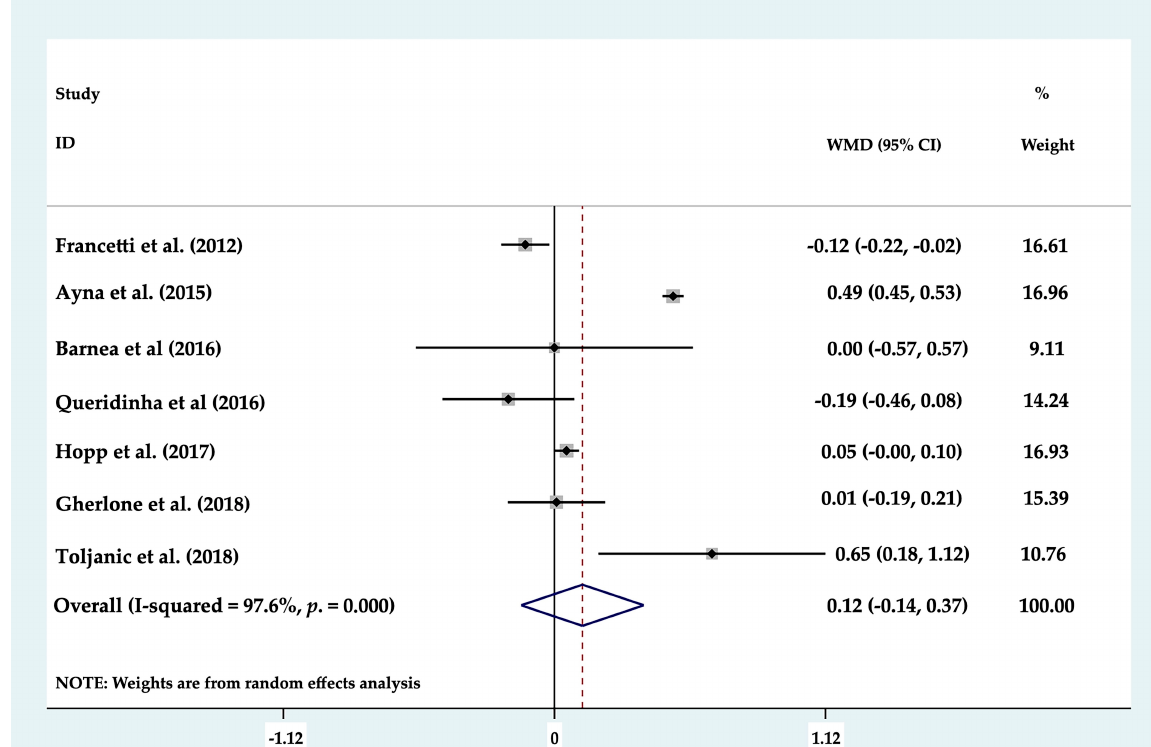
Figure 2. Forest plot of marginal bone loss. No statistically significant differences ( p ≥ 0.05) were found.